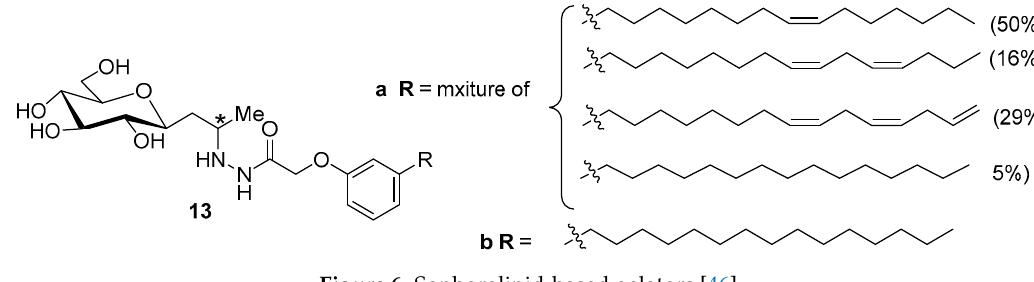
Figure 6. Sophorolipid-based gelators [46].